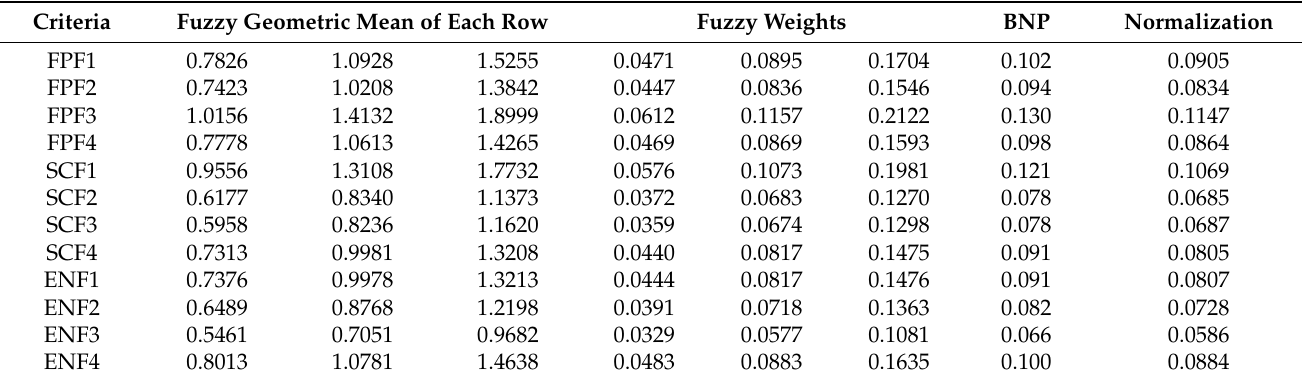
Table 1. The weight of criteria.